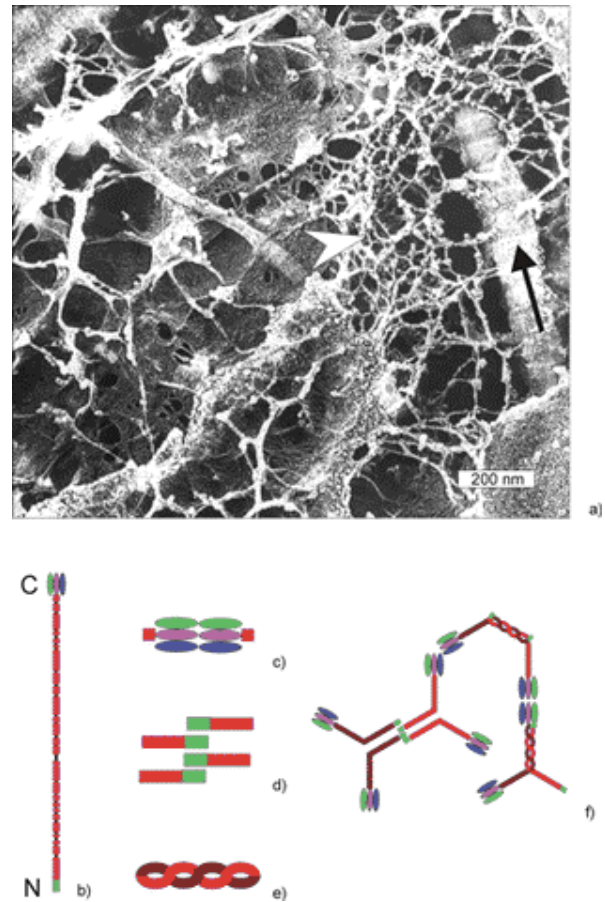
FIGURE 2. (a) Metal-shadowed replica of partially purified glomerular basement membrane. The arrowhead points to a collagen IV network. The black arrow indicates a Type I collagen fibre (Micrograph courtesy of Dr. M. Chew). (b) Diagram of a collagen IV molecule. Along the triple helical part (represented in red) numerous interruptions of the Gly-X-Y amino acid repeat are present. Linear polymerisation is observed through C-terminal interactions (c) , N-terminal interactions (d) . Lateral interactions are also observed with molecular supercoiling (e) . Collagen IV is able to form networks by linear and lateral associations (f)